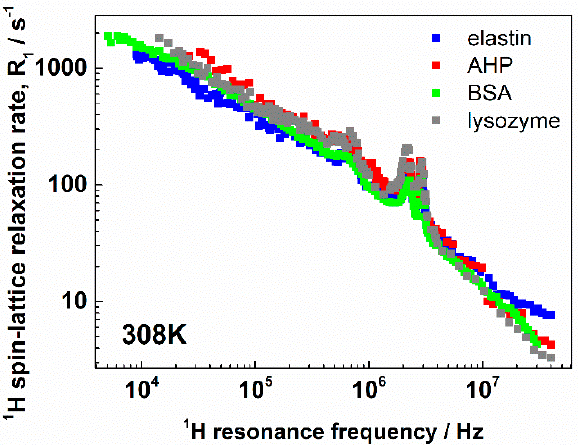
Figure 2. 1 H spin–lattice relaxation profiles for elastin, albumin from human plasma (AHP), bovine serum albumin (BSA), and lysozyme at 308 K.